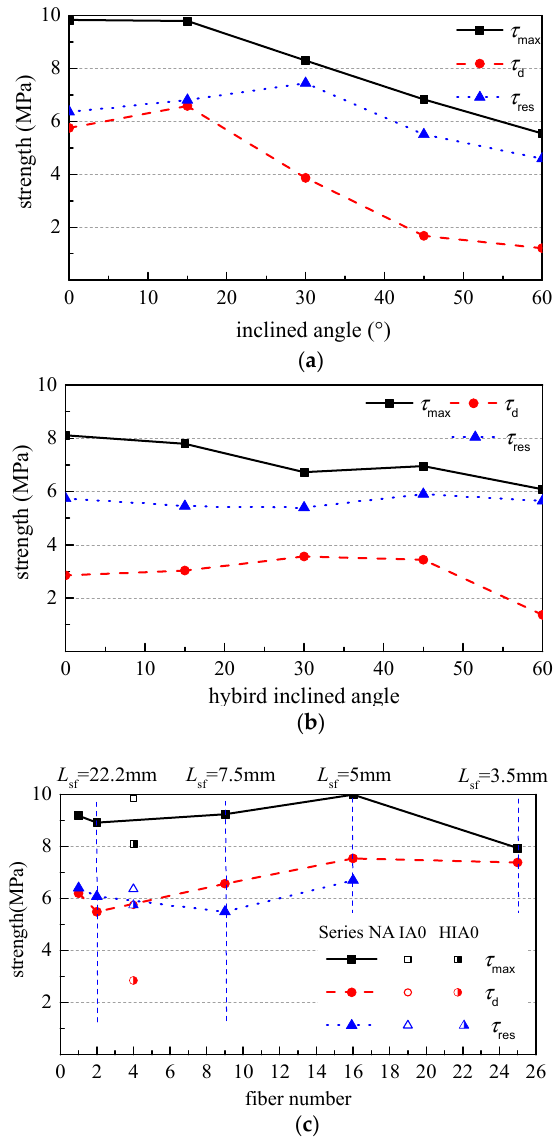
Figure 7. The bond strengths. ( a ) Series IA, ( b ) Series HIA and ( c ) Series NA. With the increase in the inclination angle, the risk of mortar cracking increases and the fiber utilization rate decreases. The nominal fiber utilization efficiency u sf decreases by 45.2% with the angle increased to 60°. The nominal strength ratio u de increases by 15% with the inclination angle increased from 0° to 15°, and then decreases by 64% with the angle increased from 15° to 60°. This illustrates that the debonding resistance is sensitive to the inclination angle. The nominal strength ratio u res increases by 38% with the inclination angle increased from 0° to 30°, and then changes a little with the continuous increase in the angle. This indicates that the loss rate of bond strength can be reduced with a larger inclination angle of steel fiber, due to the better bond retention by the compressive action of peeling off force perpendicularly on the steel fibers. Figure 7b shows the variations of τ d , τ max and τ re s of Series HIA with the hybrid incli- nation angle. Compared with Series IA, half of steel fibers aligned to the pullout direction. This lightened the effect of inclination angle on the bond of steel fibers. With the hybrid action of aligned and inclined steel fibers, the τ d of HIA2 and HIA3 are 24% and 21% higher than that of HIA0. Although the τ max still trends to decrease with the increase in the inclination angle, the decrement becomes slower. The decrement is 25% with the in- clination angle increased from 15° to 60°, which is 56.8% that of the IA4. Therefore, the reduction of τ max comes from the decreased bond strength of the inclined steel fiber in Series HIA, no hybrid effect exists among inclined and aligned steel fibers. A slight in- crease in the τ res appears with the increase in inclination angle. This is due to the better bond retention of inclined steel fiber during the pullout. Except for the large inclination angle of 60°, the smaller angle benefits to the debonding resistance and the retention of residual bond. The strength ratio u de increases 50.7% with the inclination angle from 0° to 30°, and then decreases 35.7% with the inclination angle continu- ously increased from 30° to 60°. The strength ratio u res increases 31.4% with the inclination angle from 0° to 60°. The nominal fiber utilization efficiency u sf decreased by 27.3% with the angle increased to 60°. It is almost half decrease rate compared with the regularity of u sf for series IA. It also illustrates that no hybrid effect exists among inclined and aligned steel fibers. Figure 7c shows the variations of τ d , τ max and τ re s of Series NA with the fiber number. The influence of fiber number on bond strength essentially relates to the influence of fiber spacing. There are slight decreases of the τ d , τ max , τ re s , u sf , u de and u res of NA1 compared with those of NA0. This may be due to the eccentric pullout on the two steel fibers during the loading process. In addition, the reduction rate of the bond strengths of multiply fibers compared with single fiber is smaller than that with reported in the references [32,33]. This may attribute to the different cementitious matrix and pull-out test method. When the fiber number increased to 9 for NA2, the τ d , τ max , u sf and u de are basically equal to those of NA0, while the τ re s and u res slightly decrease. When the fiber number reached to 16 for NA3, the τ d , τ max , u sf and u de increase by 20.2%, 8.1%, 8.1% and 11.7% compared with those